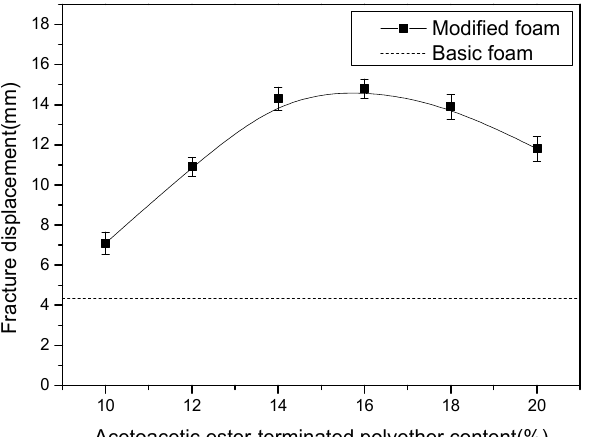
Figure 7. The effect of the acetoacetic ester-terminated polyether with different contents on the fracture displacement of the foam.